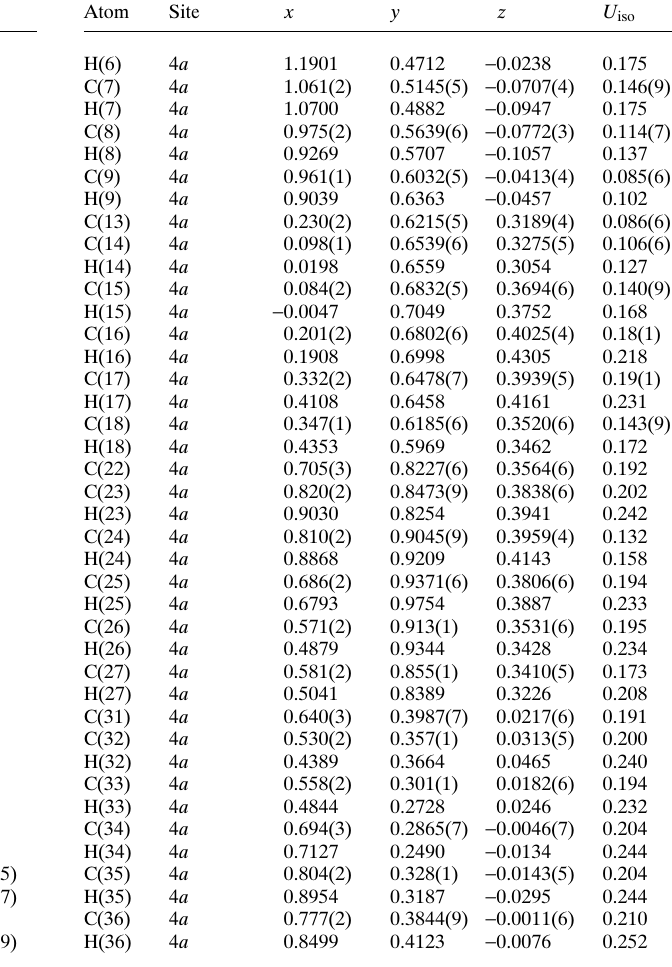
Table 2. Atomic coordinates and displacement parameters (in Å 2 )